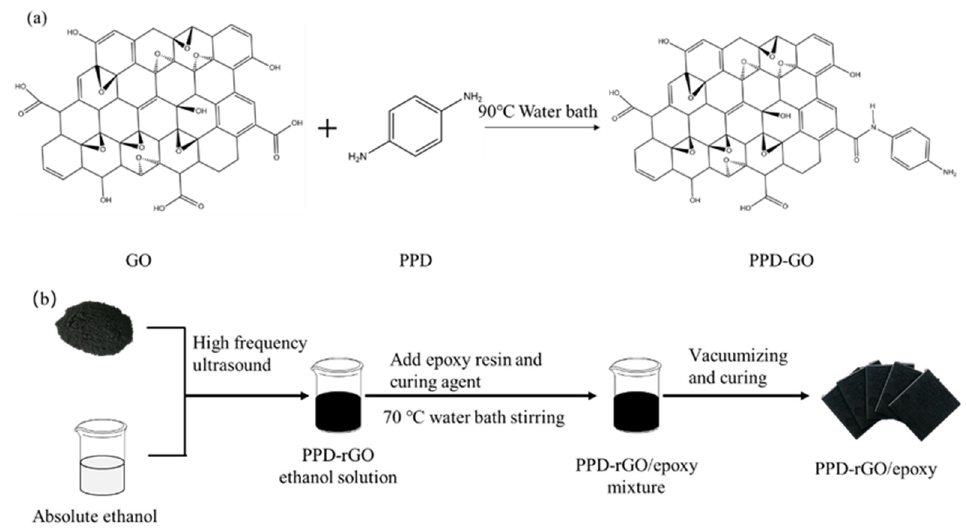
Figure 1. ( a ) Structure diagram of PPD-modified GO. ( b ) PPD-rGO epoxy composite preparation flow chart.